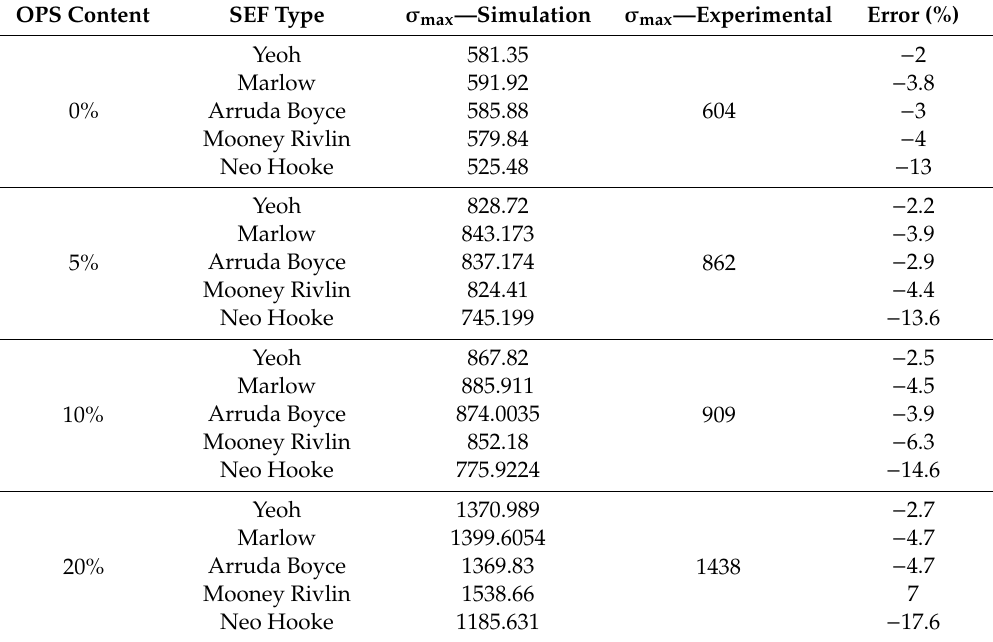
Table 3. Summary of σ max (in kN / m 2 ) and error for circular ROPS